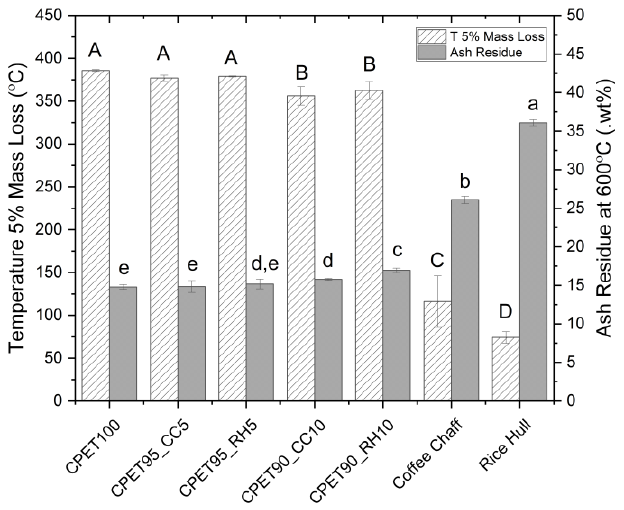
Figure 7. The temperature at 5% mass loss and ash residue at 600 °C. Data points associated with the same letter are statistically equivalent (α = 0.05); uppercase for temperature, lowercase for ash residue.